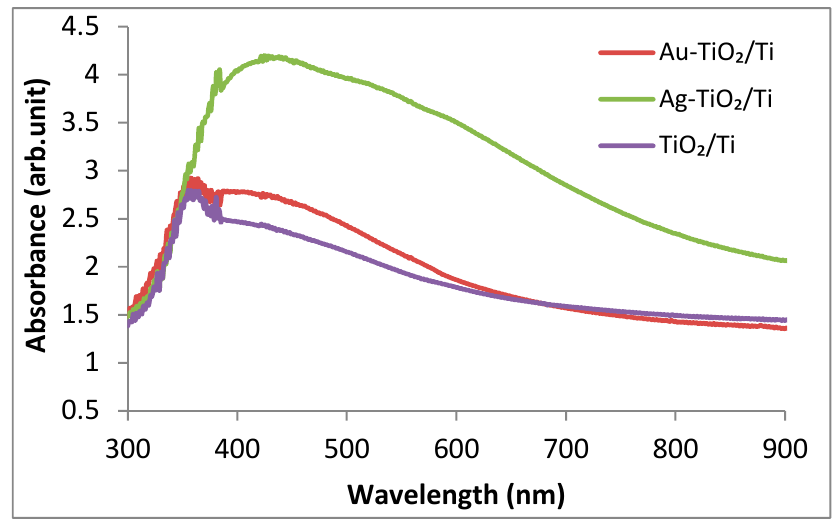
Figure 5. UV–Vis spectra of the Au–TiO 2 /Ti, Ag–TiO 2 /Ti, TiO 2 /Ti samples ranging in the 300–900 nm domain.